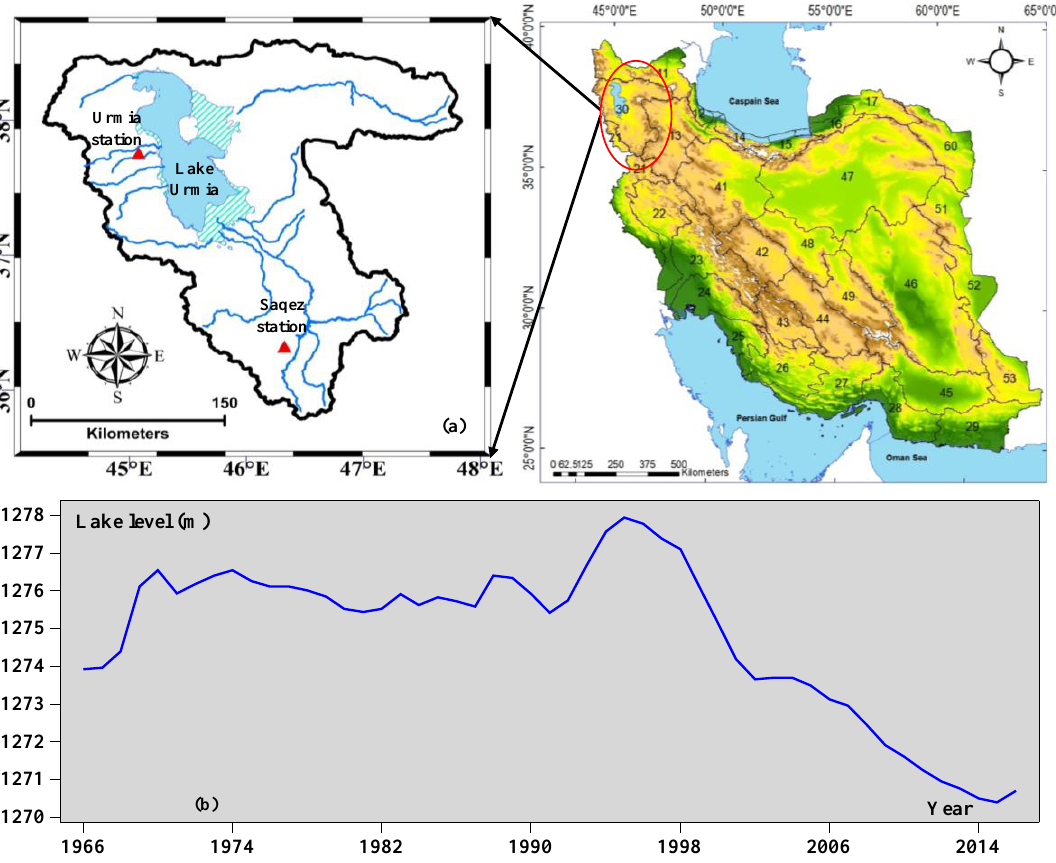
Figure 1. ( a) Maps showing the location of Lake Urmia and its basin in northwestern Iran and of the two meteorological stations from which data were taken, and ( b ) changes in the water level in Lake Urmia, 1965-2018.